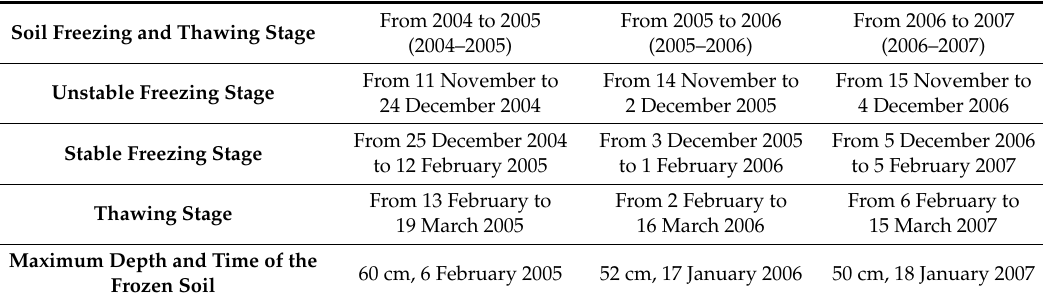
Table 3. Division of soil freezing and thawing